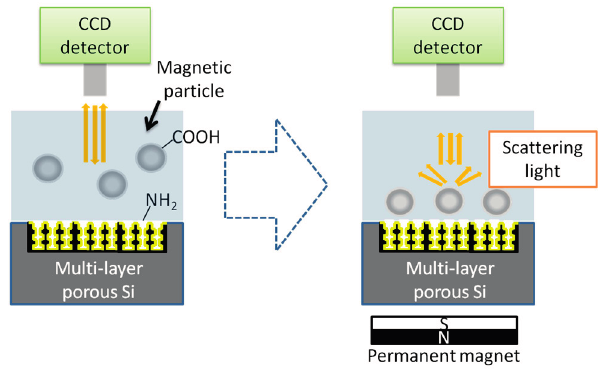
Figure 17. The schematic image of the nano-sized target particles detection based on multi-layer-PSi. Adapted from [13].